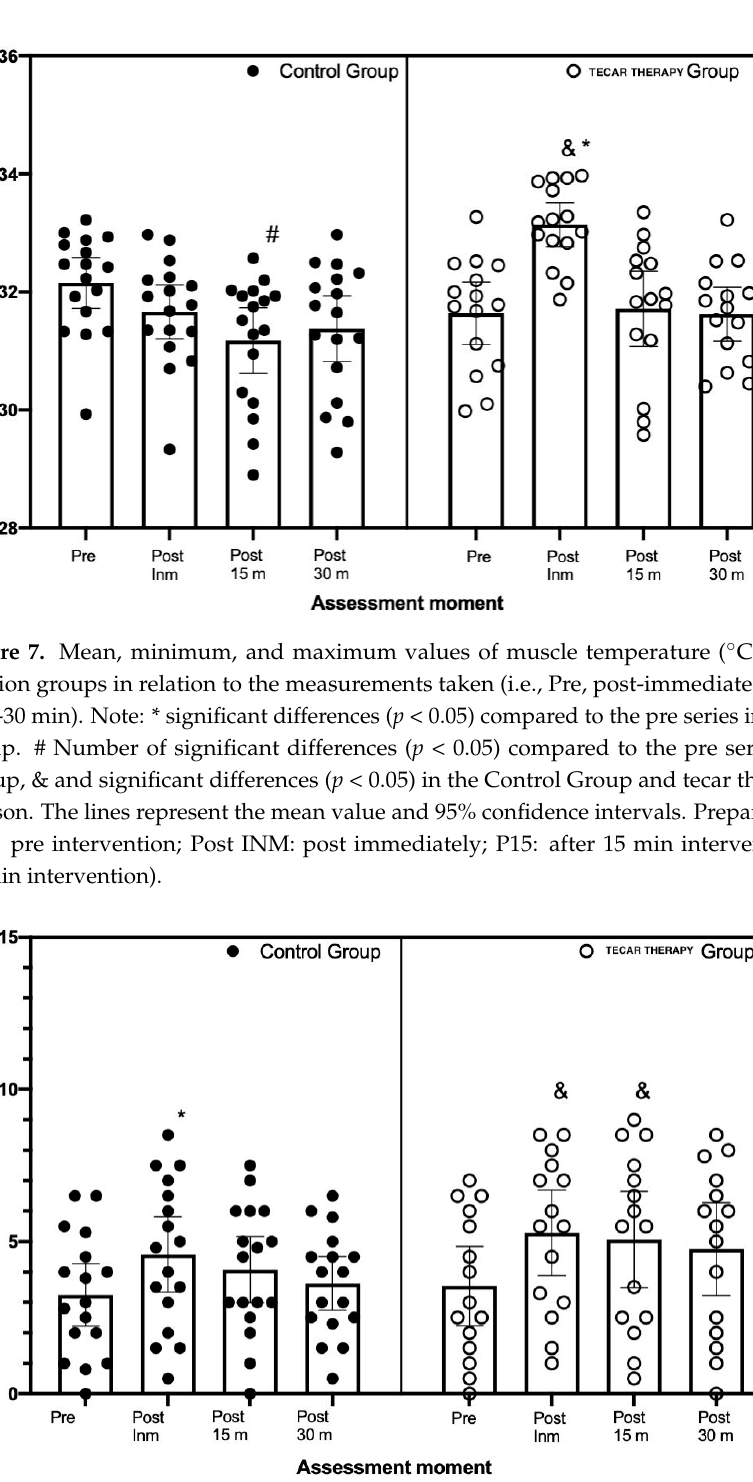
Figure 8. Mean, minimum, and maximum values of hyperalgesia (VAS scale) in the two intervention groups in relation to the measurements taken (i.e., pre, post-immediate, post-15 min, and post-30 min). Note: * significant differences ( p < 0.05) compared to the pre series in the Control Group, and & significant differences ( p < 0.05) compared to the pre series in the tecar therapy group. The lines represent the mean value and 95% confidence intervals. Prepared by the authors. (Pre: pre intervention; Post INM: post immediately; P15: after 15 min intervention; PI 30: after 30 min intervention).